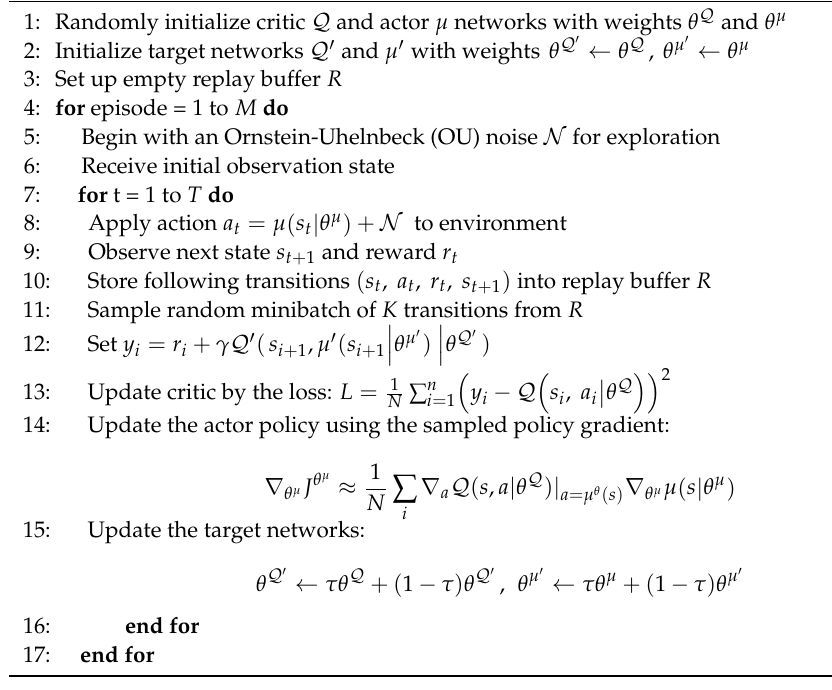
Figure 6. Actor critic framework of the DDPG algorithm. 4. Performance Evaluation